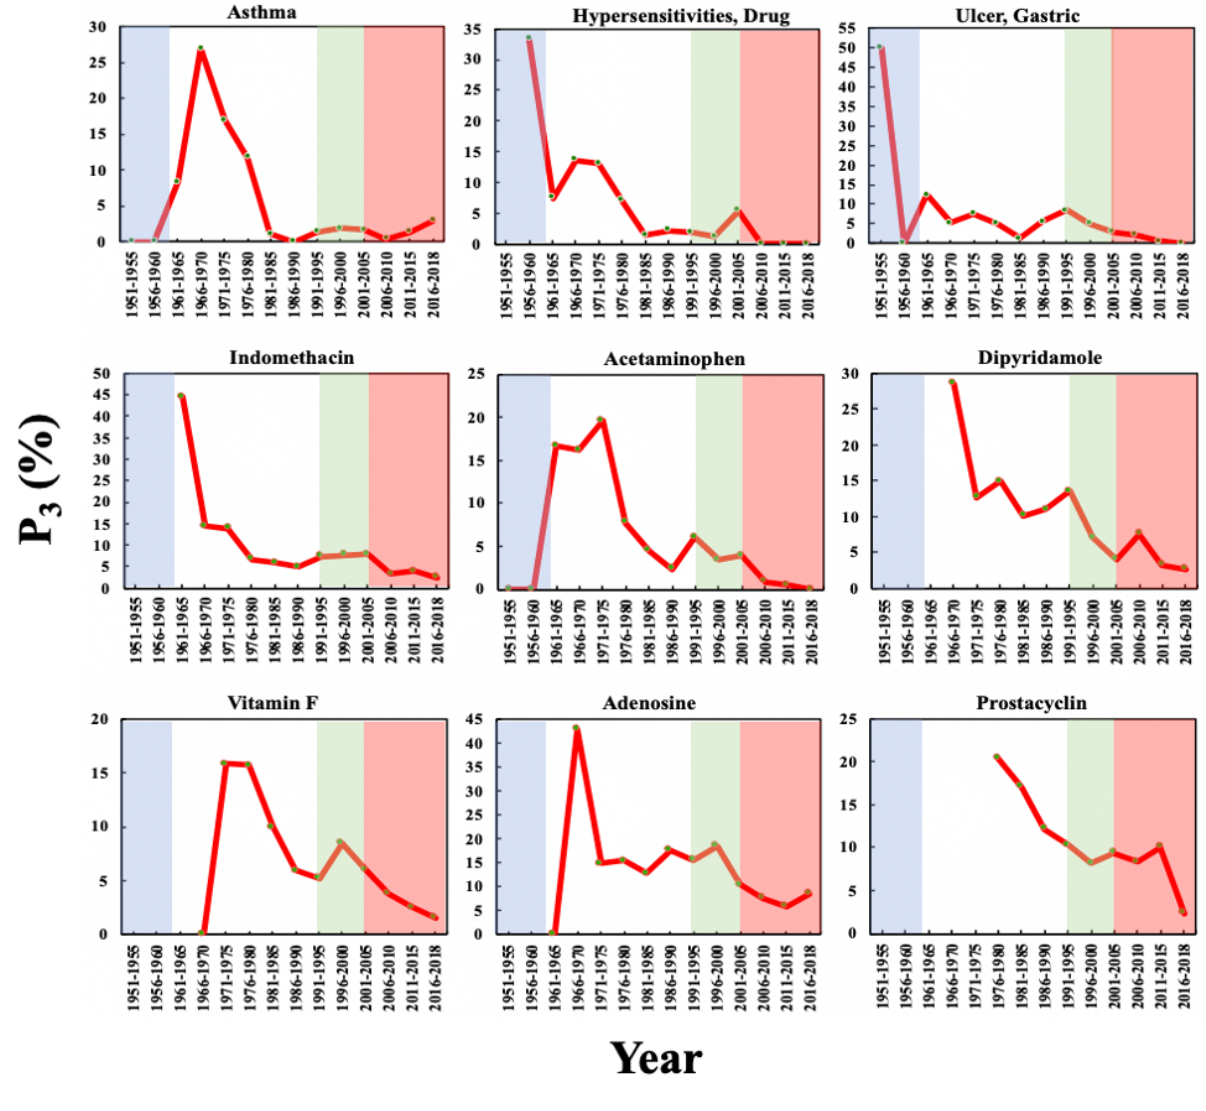
Figure 5. The Prestige Index (P 3 ) of the biomedical entities on the pharmacological mechanisms and side effects of aspirin over time. The background colors show the 4 phases of aspirin research.